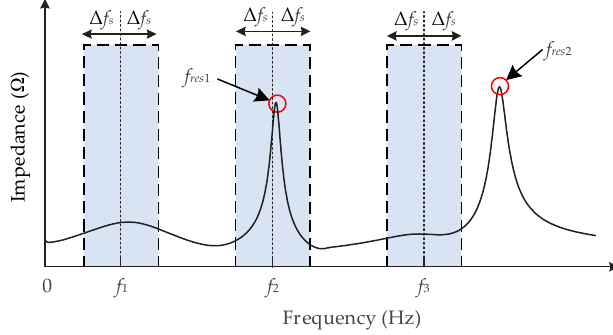
( b ) Figure 9. Effect of components on the resonance mode of: ( a ) f = 305 Hz; ( b ) f = 760 Hz. From the aforementioned analysis, it can be seen that the optimal connection number of the inverters can be obtained by calculating the MFS of the C eq (or L eq ). In addition, the resonance frequency needs to be calculated by RMA again to correct the error. 4. Connection Optimization Scheme of Inverter 4.1. Concept of Security Region Harmonic amplification is caused by matching the harmonic sources with the natural resonance frequencies of the grid. In other words, harmonic amplification can be avoided by keeping the natural resonance frequencies away from the frequency of the harmonic sources instead of weakening the harmonic sources. In addition, harmonic source fre- quencies often show a specific regularity. For example, harmonic source frequencies of the power-electronic grid are generally 6 k ± 1 ( k = 1, 2, …, n ). When the natural resonance frequencies are far from the harmonic source frequencies, such as (6 k ± 3), it can be said that these frequencies can be regarded as “safe”. Conversely, frequency ranges close to the harmonic source frequencies are “unsafe”.